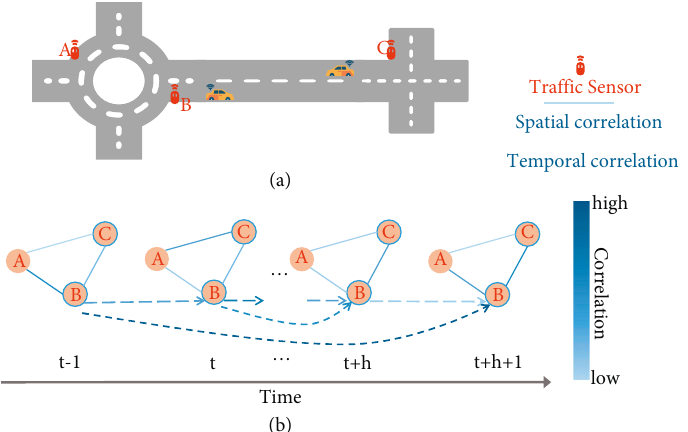
Figure 1: Dynamic spatial-temporal correlation in traffic forecasting. (a) Illustration of sensor distribution in the road network. (b) Dynamic spatial and temporal